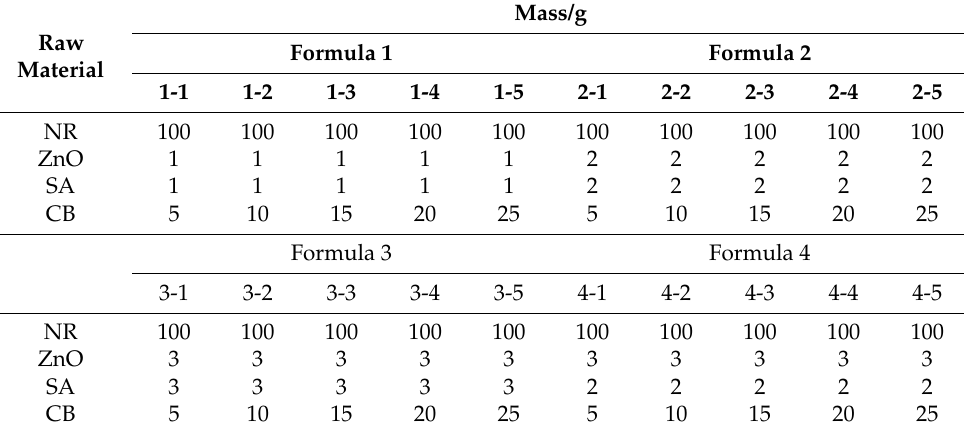
Table 3. The rubber mixing formulas.